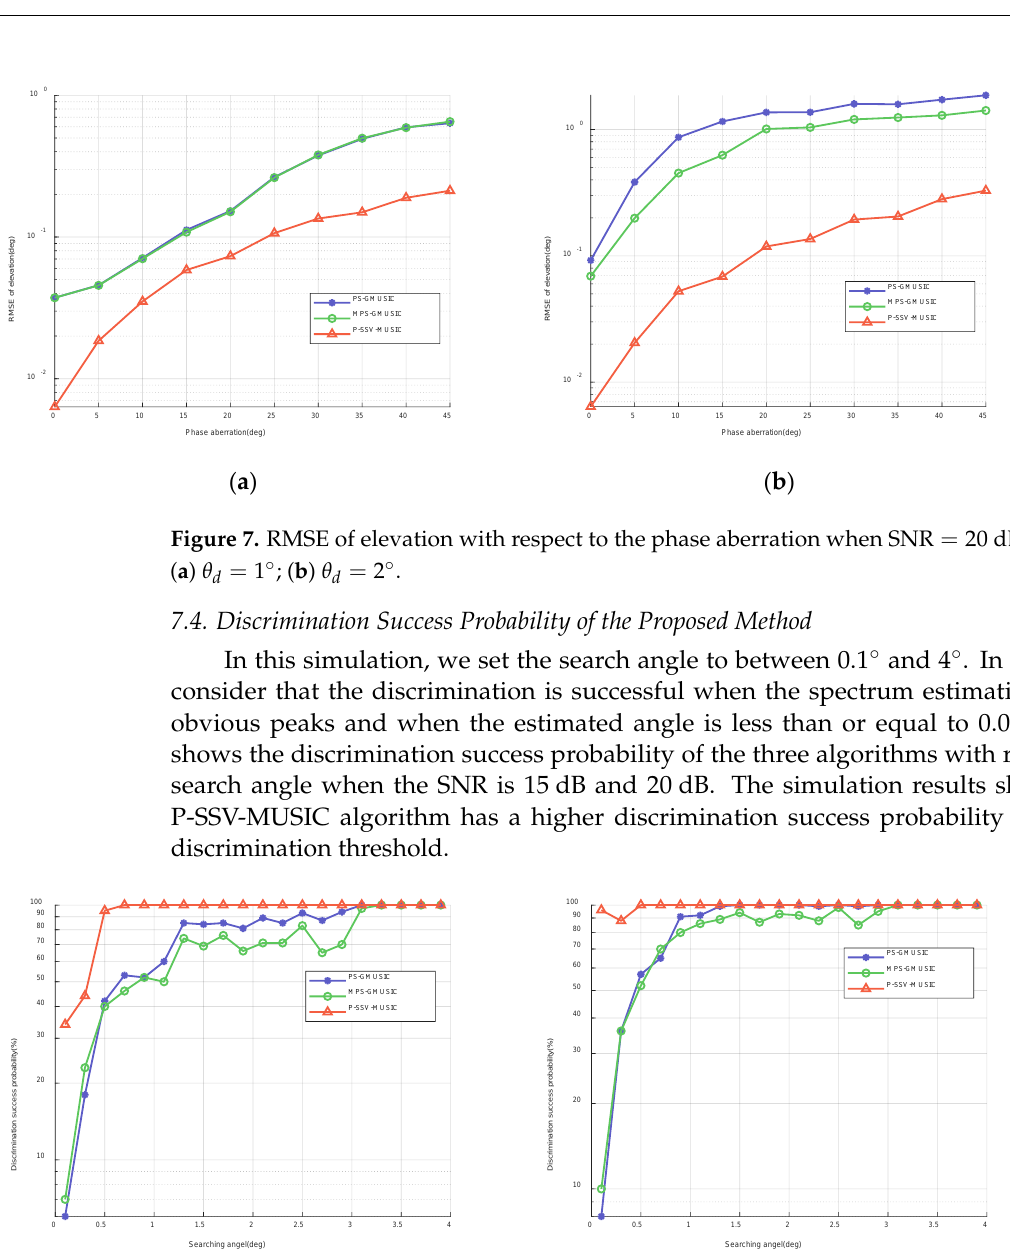
( b ) Figure 6. RMSE of elevation with respect to the snapshot number when SNR 20 dB = : ( a ) 1 d θ =  ; ( b )